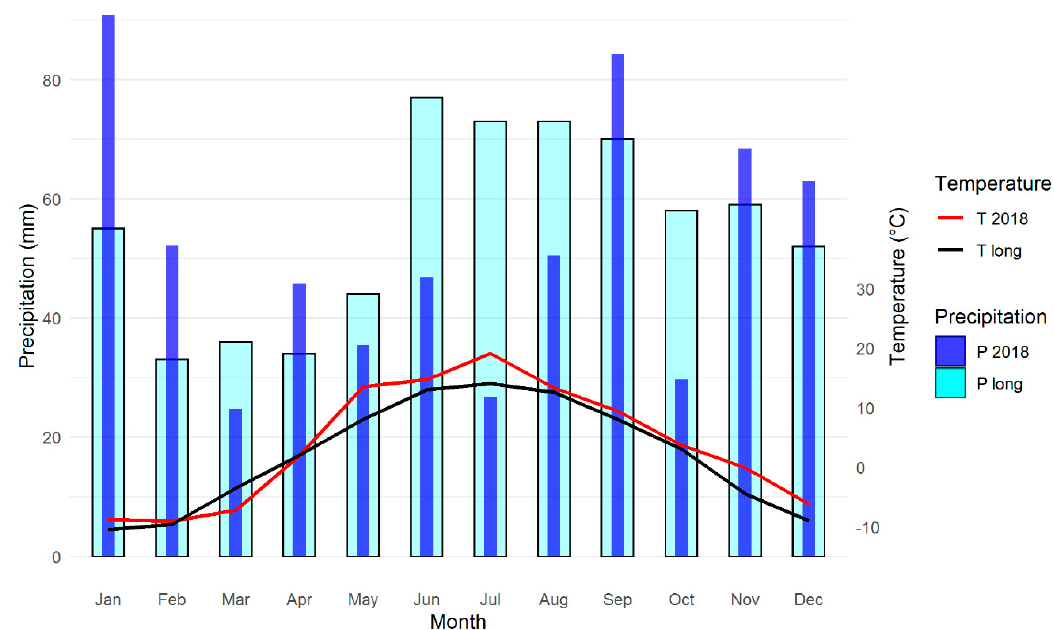
Figure 1. Mean temperature (T) and cumulative precipitation (P) monthly values for the study area. Long-term average values for the period 1961–1990 (“long”) are shown together with the mean values recorded in 2018 (“2018”). Temperature data were measured at Evenstad’s weather station (4 km from study area), precipitation data were measured at Rena’s weather station (~30 km south of study area). Source of the data: Norwegian Meteorological Institute (www.yr.no).